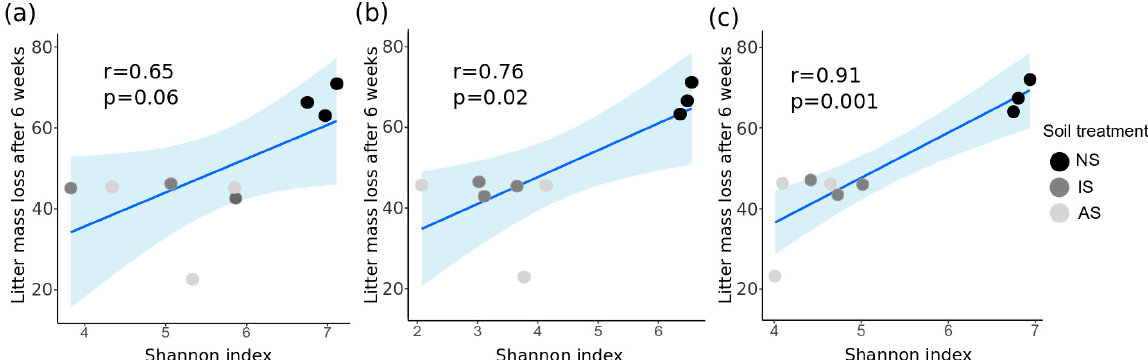
Figure 3. Scatter plots and regression lines showing the correlation between litter mass loss after 6 weeks and Shannon– Weaver diversity index on week − 2 ( a ), week 0 ( b ), and week 6 ( c ). Additionally, the 95% confidence interval, the Pearson’s correlation coefficient (r), and p -value ( p ) are displayed. Black, gray, and light gray dots indicate different soil treatments (NS: natural soil, IS: inoculated soil, and AS: autoclaved soil, n = 3). Variations in beta-diversity of the bacterial communities are displayed in Figure 4.